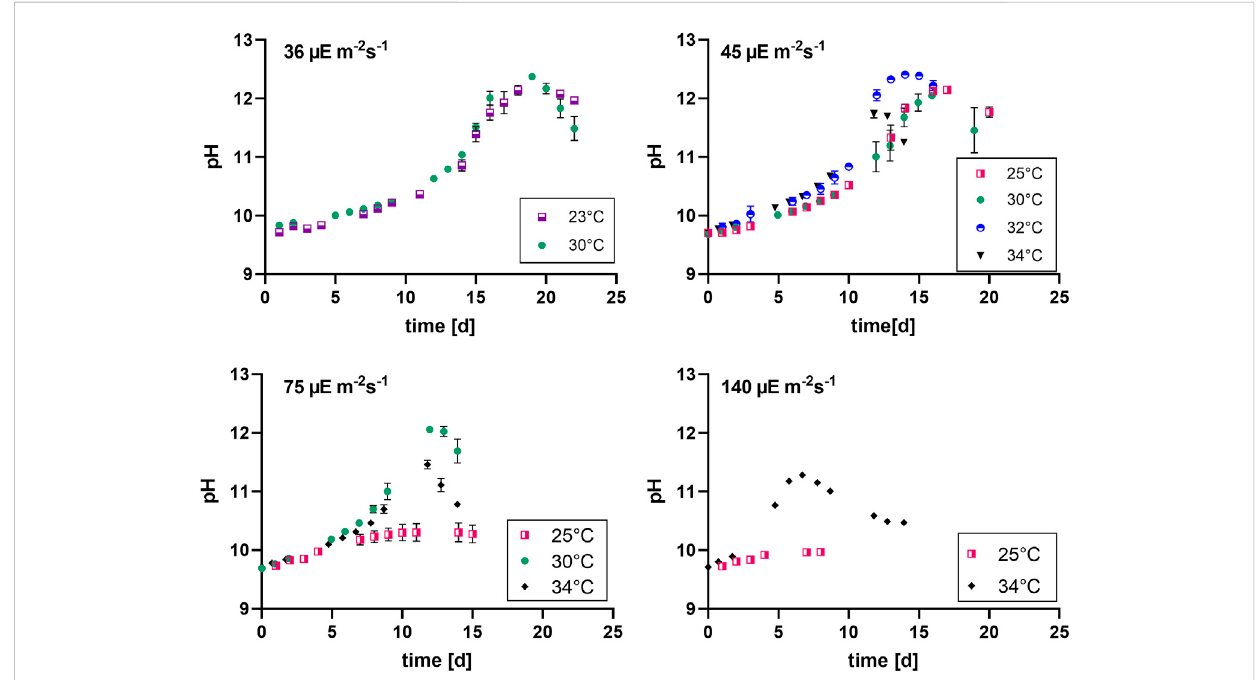
FIGURE 3 pH evolution at different light intensities (36, 45, 75 and 140 µmol photons m -2 s -1 ), n = four to eight, all values are presented as mean ± SD.